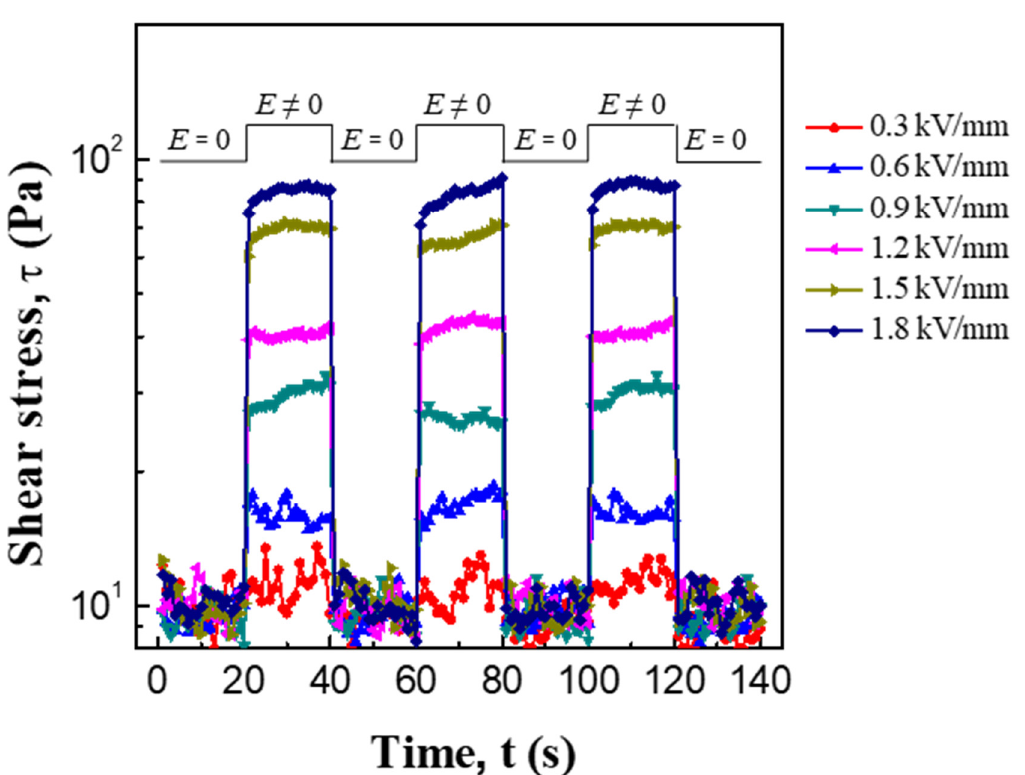
Figure 5. Shear stress vs. time of the GO/PDPA microsheet composites-based ER fluid influenced by alternating on–off state under different electric field at a fixed shear rate of 1.0 s −1 . (cid:48) Dielectric characteristics (dielectric constant ε and dielectric loss ε ”) are one of the crucial factors